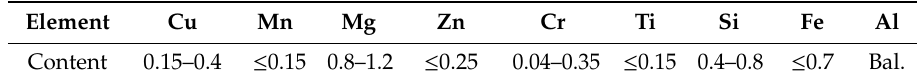
Table 1. Chemical composition of 6061-Al (wt %).